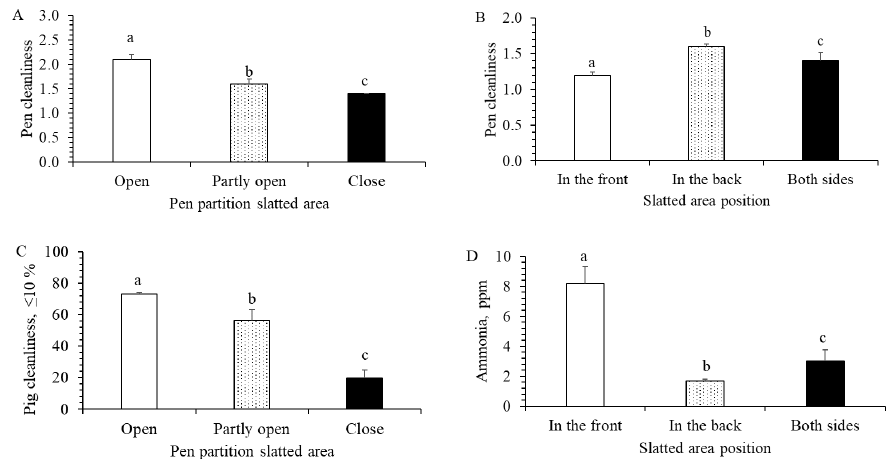
Figure 2. Effects of pen design on pen and pig cleanliness and ammonia concentration. ( A ) Pen cleanliness and pen partition of slatted floor (F 3472 = 3.8; p = 0.010). ( B ) Pen cleanliness and slatted area position (F 3472 = 5.3; p < 0.010). ( C ) Pig cleanliness and pen partition slatted area (F 3472 = 4.1; p = 0.007). ( D ) Ammonia concentration and slatted area position (F 3472 = 4.3; p = 0.008). a, b, c = means with different superscripts are significantly different ( p < 0.05).